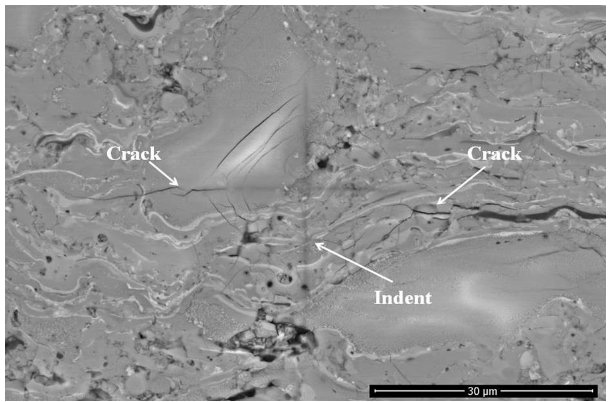
Figure 6. Microcracking propagation from the Vickers indentation in the zircon ‐ based ceramics coating (SEM, back ‐ scattered electron mode).